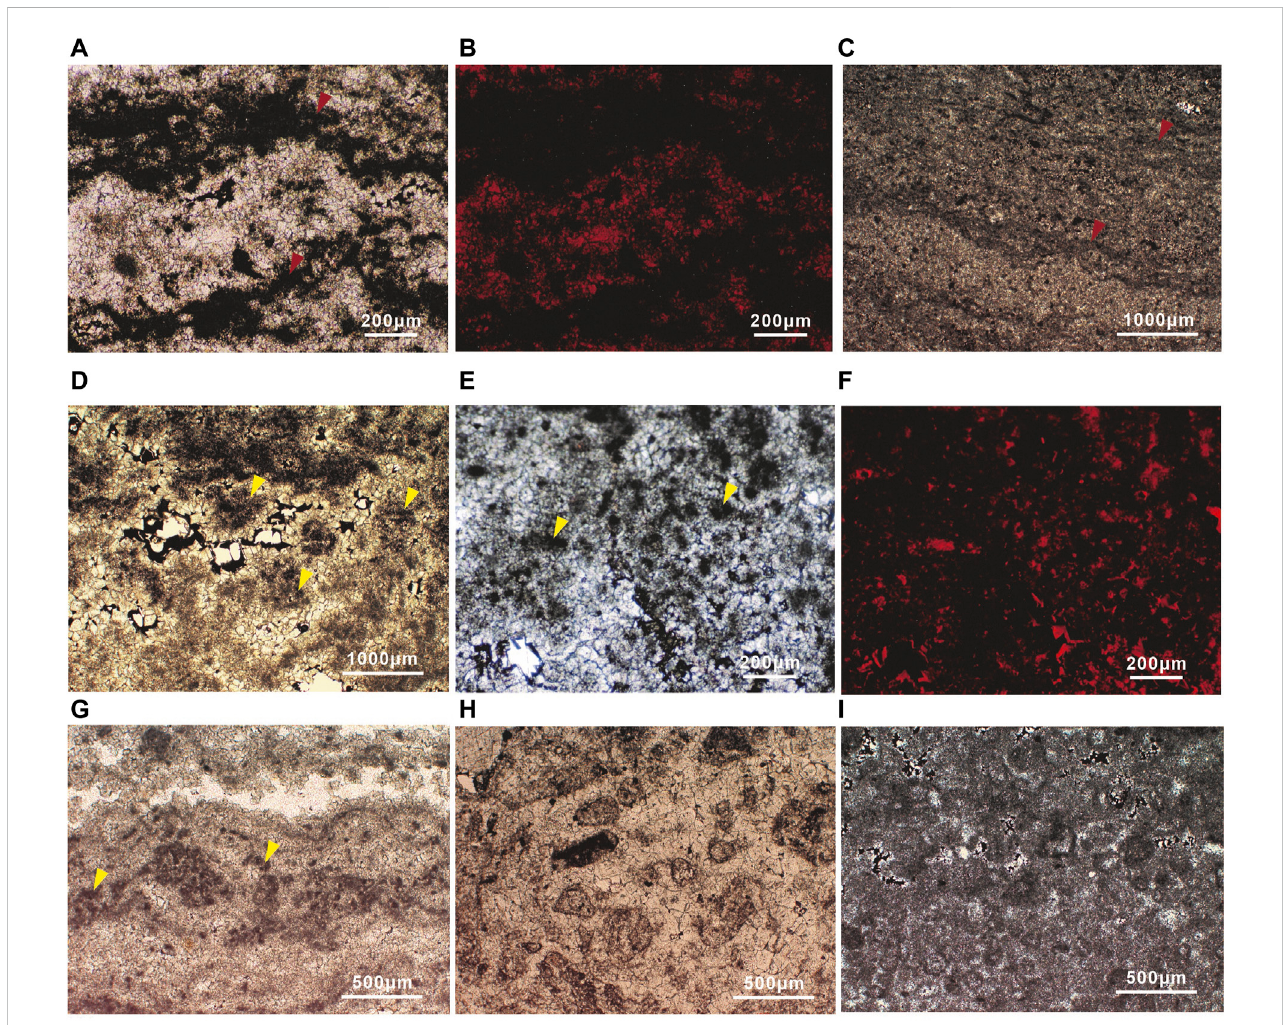
FIGURE 3 Micro-characteristics of main microbialites and non-microbialites. (A) MX105, 5359.5 m, light-grey wavy stromatolite. (B) (A) under cathode luminescence (CL). (C) GS21,5226.36 m,dark-grey wavy stromatolite. (D) MX51, 5338.5 m,spotted thrombolite. (E) MX39, 5302.6 m,spotted thrombolite. (F) (E) under CL. (G) GS20, 5201.99 m, layered thrombolite. (H) MX105, 5303.3 m, dolograinstone. (I) GS20, 5220.28 m, dolopackstone. (Red arrows indicate the Girvanella-like fabrics. Yellow arrows indicate the Renalcis-like